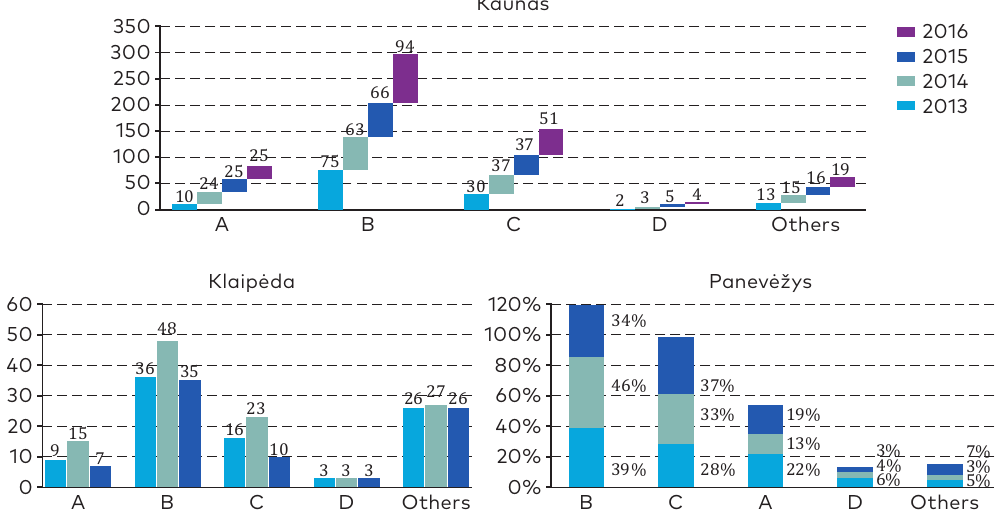
Figure 7. Type of collisions between two motor vehicles in the Lithuanian cities Kaunas, Klaipeda and Panevėžys. A – Counter-collisions; B – Collisions moving in the same direction; C – Left-hand collisions (turns); D – Right-hand